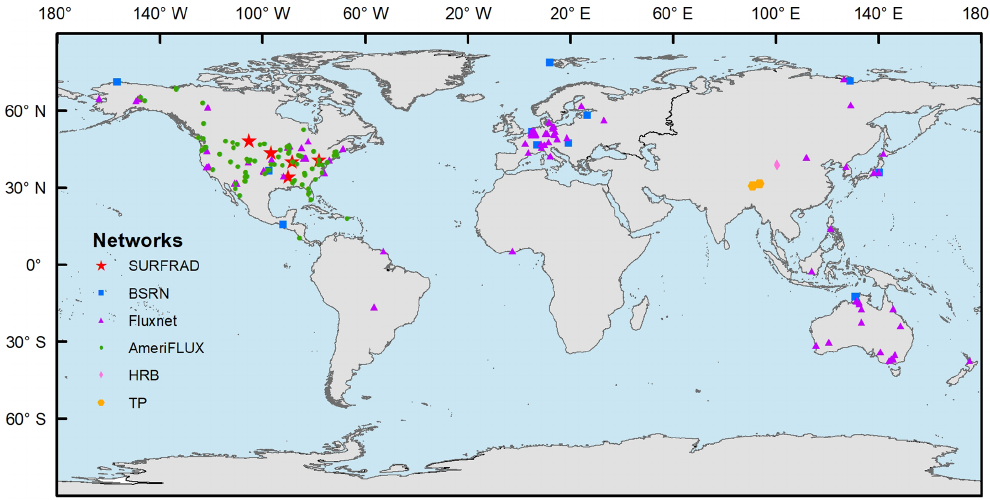
Figure 2. Global distribution of the 201 LST sites utilized. The abbreviations used in the figure are as follows: SURFRAD – Surface Radiation Budget, BSRN – Baseline Surface Radiation Network, HRB – Heihe River basin (HRB), and TP – Tibetan